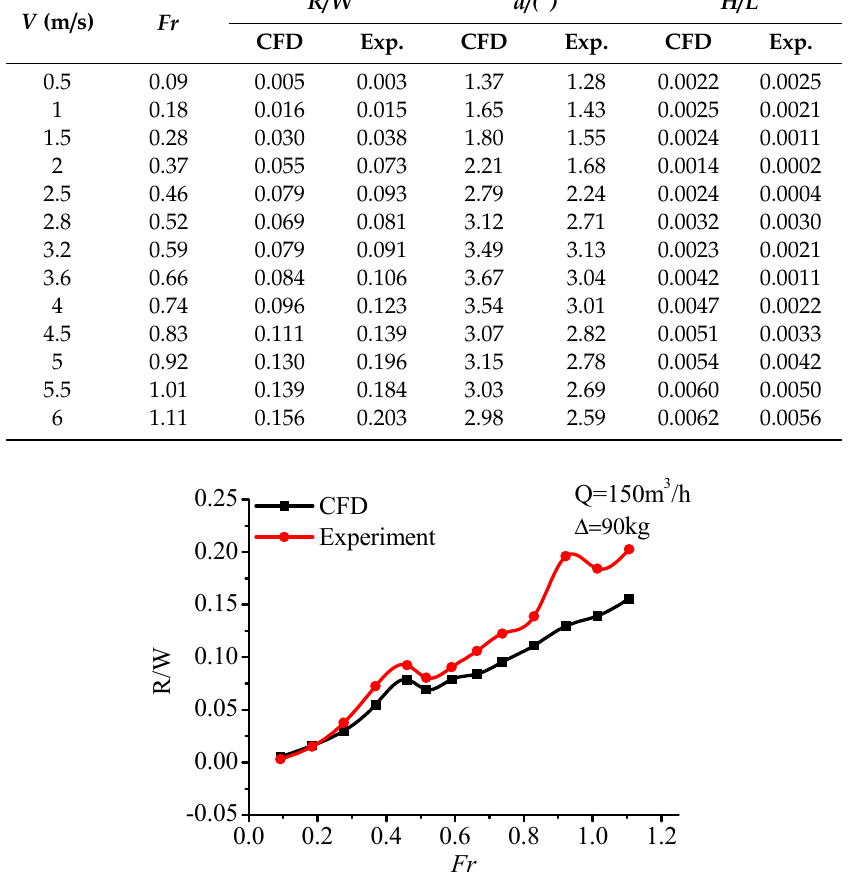
Figure 17. Resistance curves of CFD and experiment ( Δ = 90 kg, Xgm = 150 mm, Q = 150 m 3 /h).